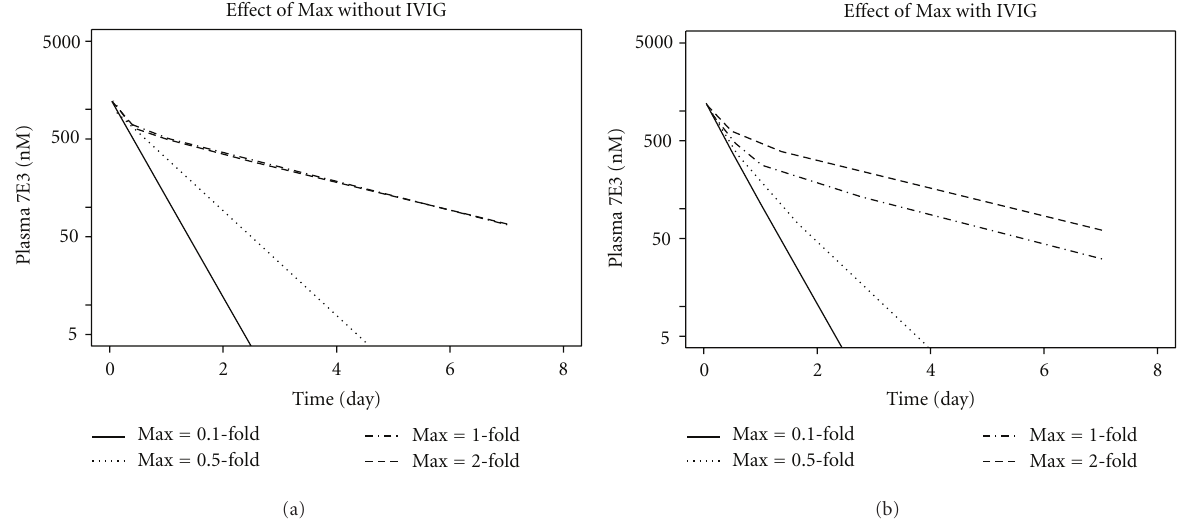
Figure 5: Sensitivity tests for Max. The e ff ect of di ff erent MAX values on the plasma 7E3 pharmacokinetics was simulated in the presence or absence of IVIG (2g/kg) using the rat PK model. The tested range was 0.1- to 2-fold the estimated Max (108 μ M).